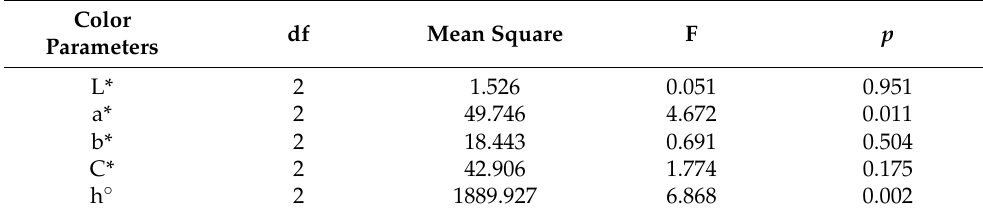
Table 2. The ANOVA results of the color parameters of